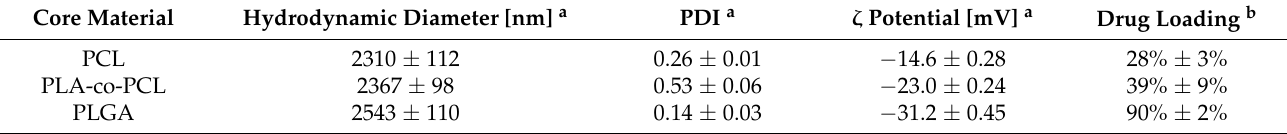
Table 2. Selected properties of fabricated polyester